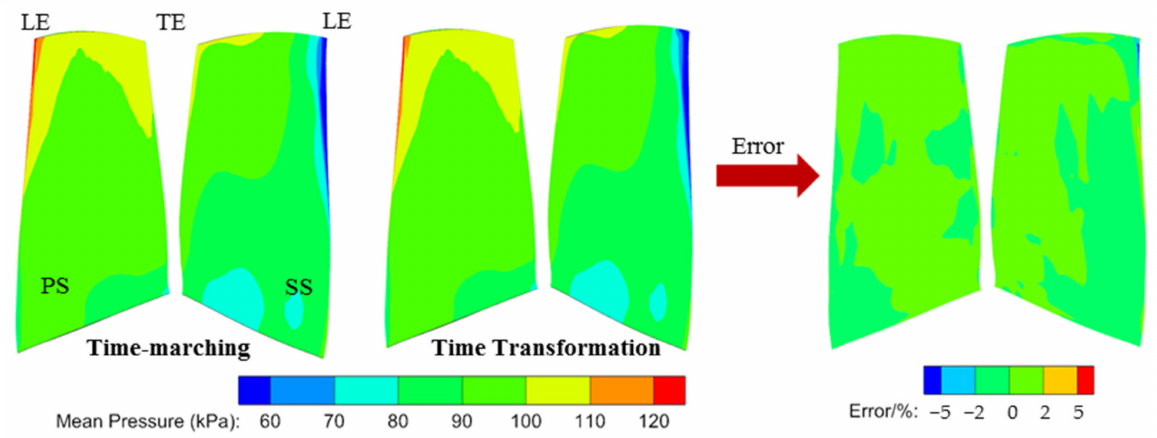
Figure 15. Mean pressure amplitude distribution of rotor blade, error = ( P TT − P TM ) / P TM